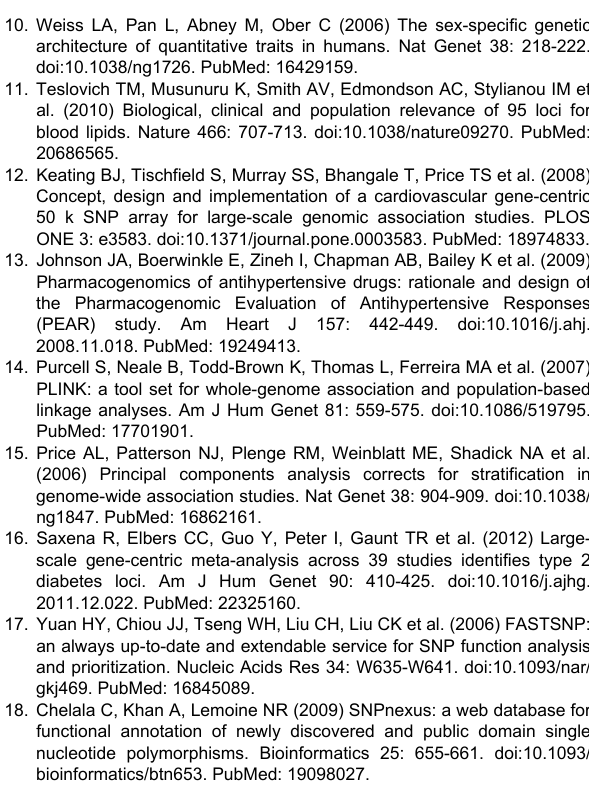
Table S3. Sensitivity analyses for FTO rs12595985 in African Americans for atenolol induced changes in HDL-C.